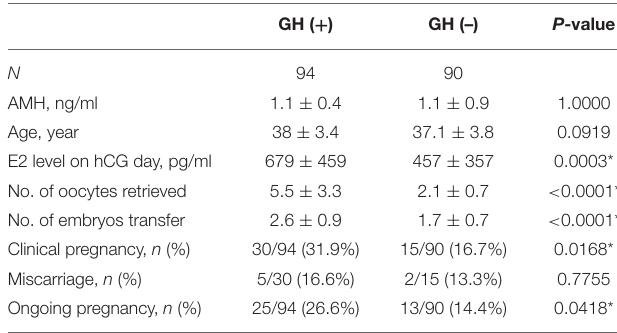
TABLE 1 | Clinical parameters and outcomes of poor-responders with GH ( + ) and GH (–)